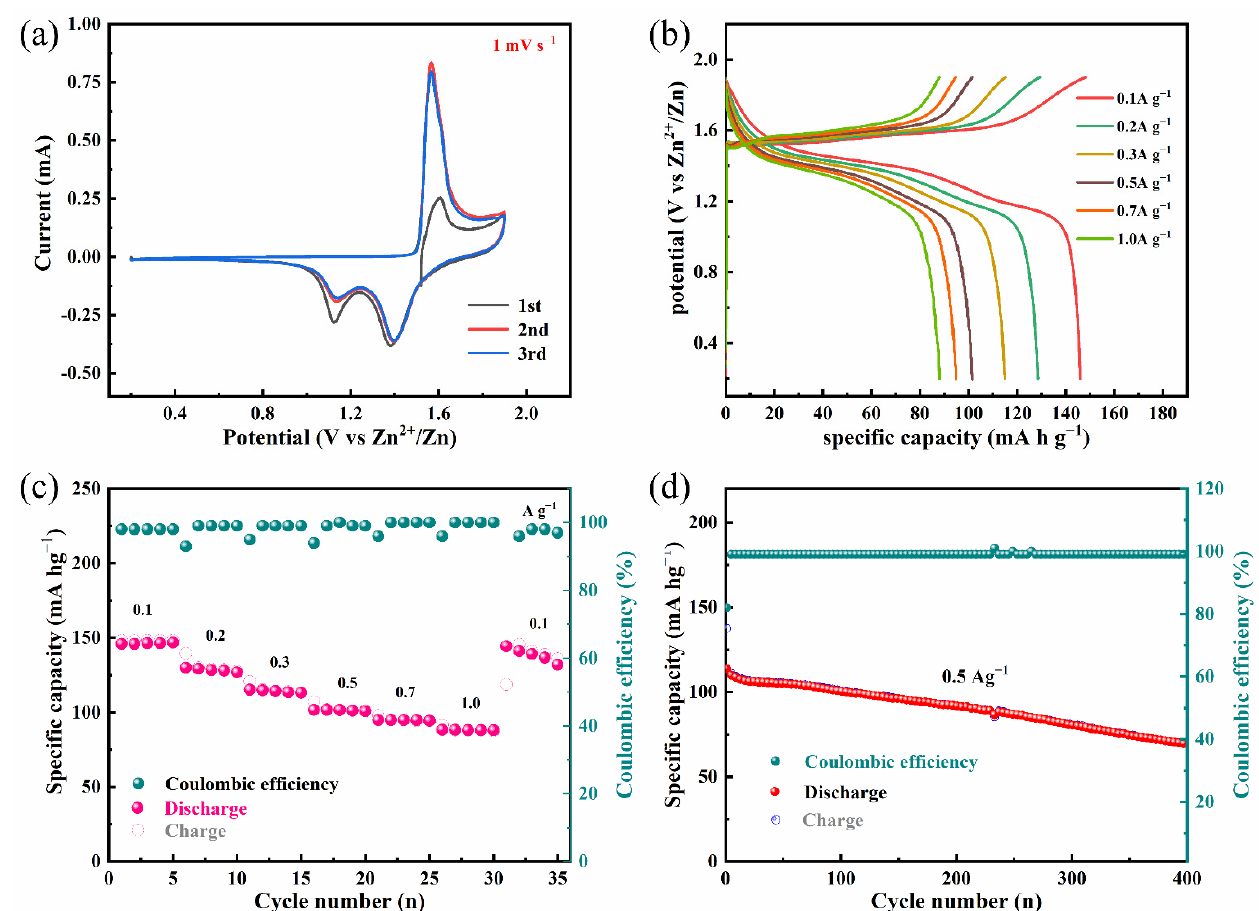
Figure 4. Electrochemical performance of Mn(OH) 2 //Zn ZIB in coin cells. ( a ) CV curves scanned at 1 mV s − 1 . ( b ) GCD curves tested at various current densities (0.1–1 Ag − 1 ). ( c ) Rate performance detected at various specific currents from 0.1 to 1.0 Ag − 1 . ( d ) Cycling stability of the Mn(OH) 2 //Zn coin cells cycled at 0.5 Ag − 1 .